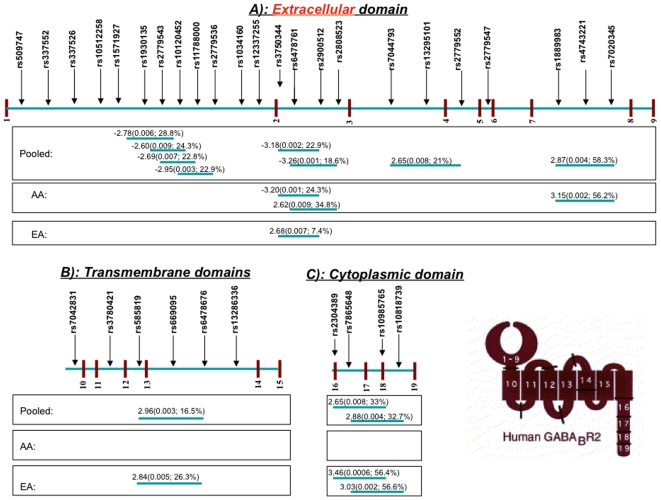
Physical location of detected significant major haplotypes on three functional domains of GABBR2.Vertical lines indicate exons; horizontal lines indicate introns in GABBR2. Arrows signify the physical location of SNPs within each protein domain. The configuration of the GABAB2 subunit protein is shown, containing numbers that correspond to the exons represented by vertical hash marks. Exons 1–9 are in the binding domain, exons 10–15 are in the transmembrane domains, and exons 16–19 are in the cytoplasmic domain of the receptor protein. Significant haplotypes are indicated for each sample group, including the Z score followed by P value and frequency in parentheses.